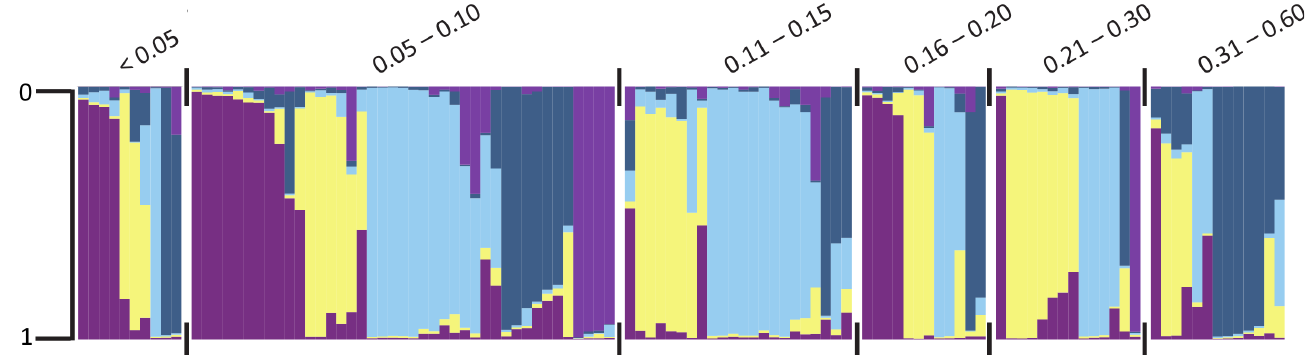
Fig 2. Population structure of pepper ( Capsicum annuum ) grouped by pericarp thickness categories. Individuals are represented by their proportionate membership (0 to 1) in cluster 1 (purple), cluster 2 (light yellow), cluster 3 (sky blue), cluster 4 (steel blue), or cluster 5 (orchid). A white space and black tick marks separate subgroups of individuals.